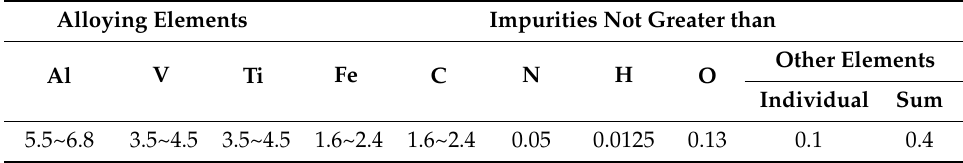
Table 1. Chemical composition of Ti6Al4V titanium alloy (%) (Data from [23]). Alloying